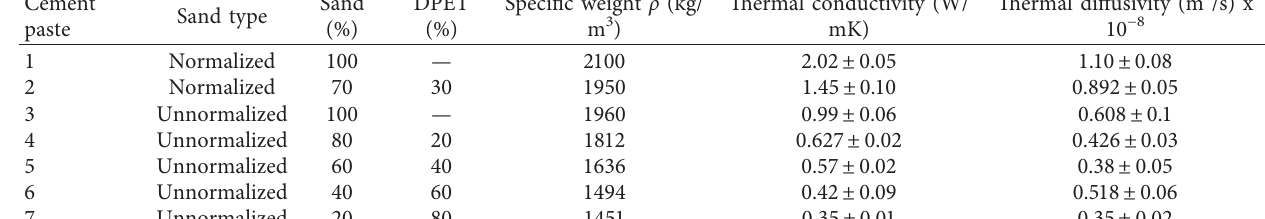
Table 3: Thermal conductivity and thermal diffusivity values of the seven mixtures investigated. Cement